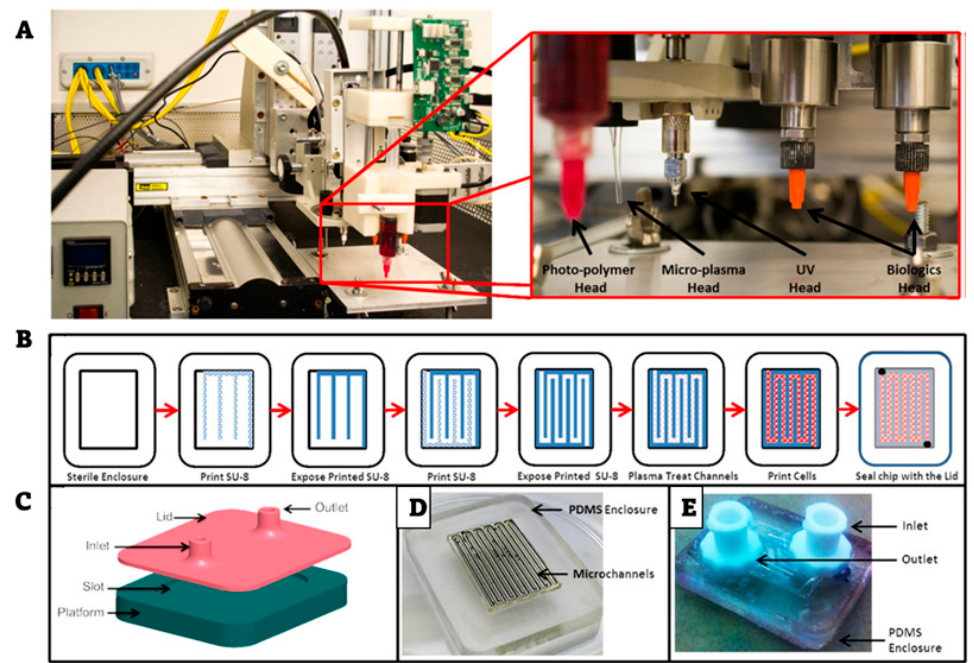
Figure 15. ( A ) Annotated photograph of the fabrication system. ( B ) Schematic representation of the process. ( C ) Illustration of the PDMS enclosure. ( D ) Reprinted and edited with permission granted by Copyright Clearance Center, Inc. (“CCC”). Photograph of the fabricated channels on the PDMS enclosure. ( E ) Photograph of the completed cell-laden microfluid. Published in Biofabrication by IOP